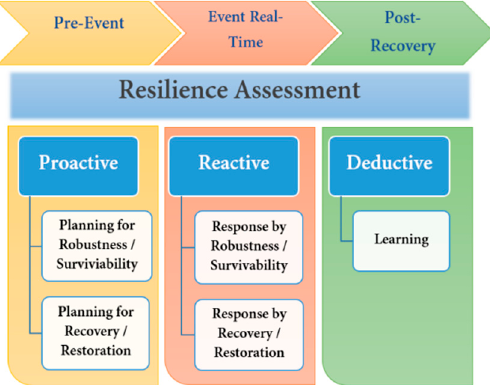
Figure 4. Options for resilience evaluation timing and associated objectives.